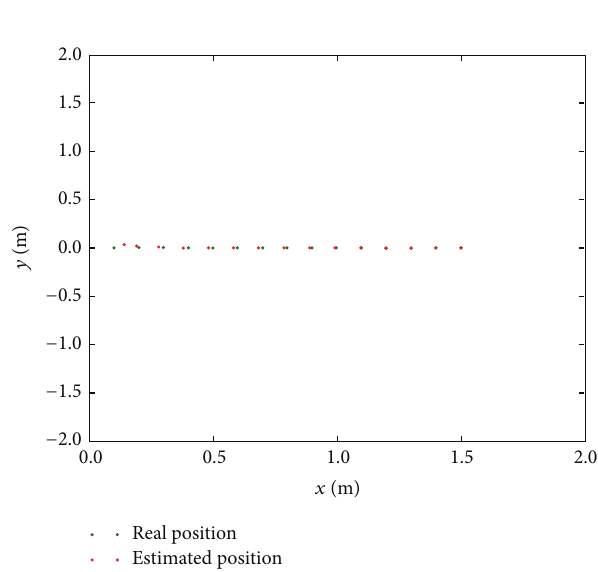
Figure 4: The experiment motion results of robot with closed-loop